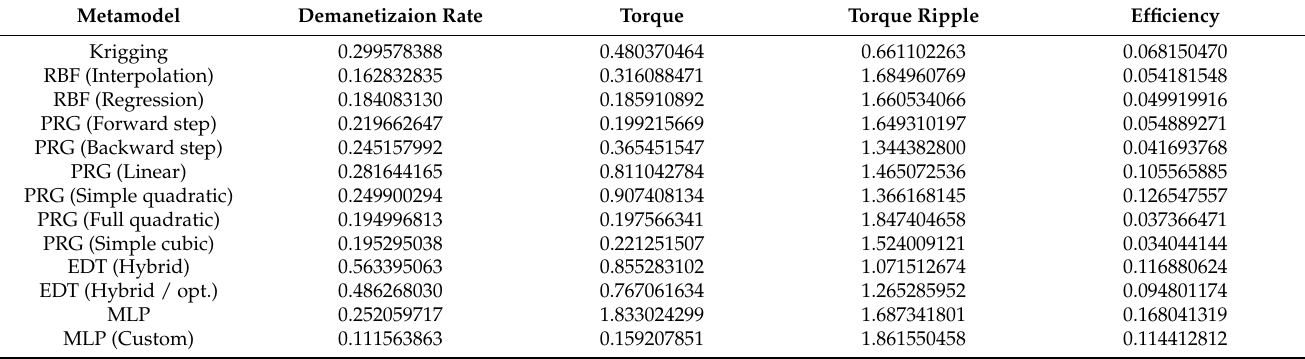
Table 4. Root mean squared error (RMSE) test results of metamodels.